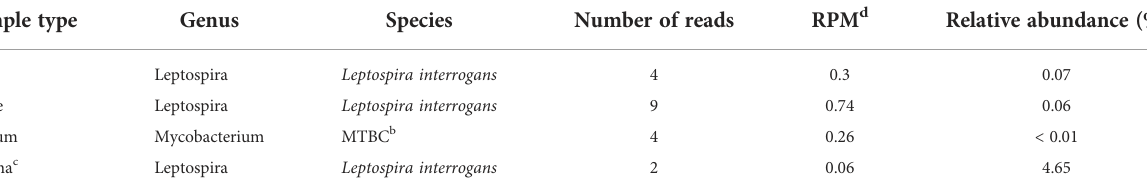
TABLE 2 Pathogens detected by mNGS.